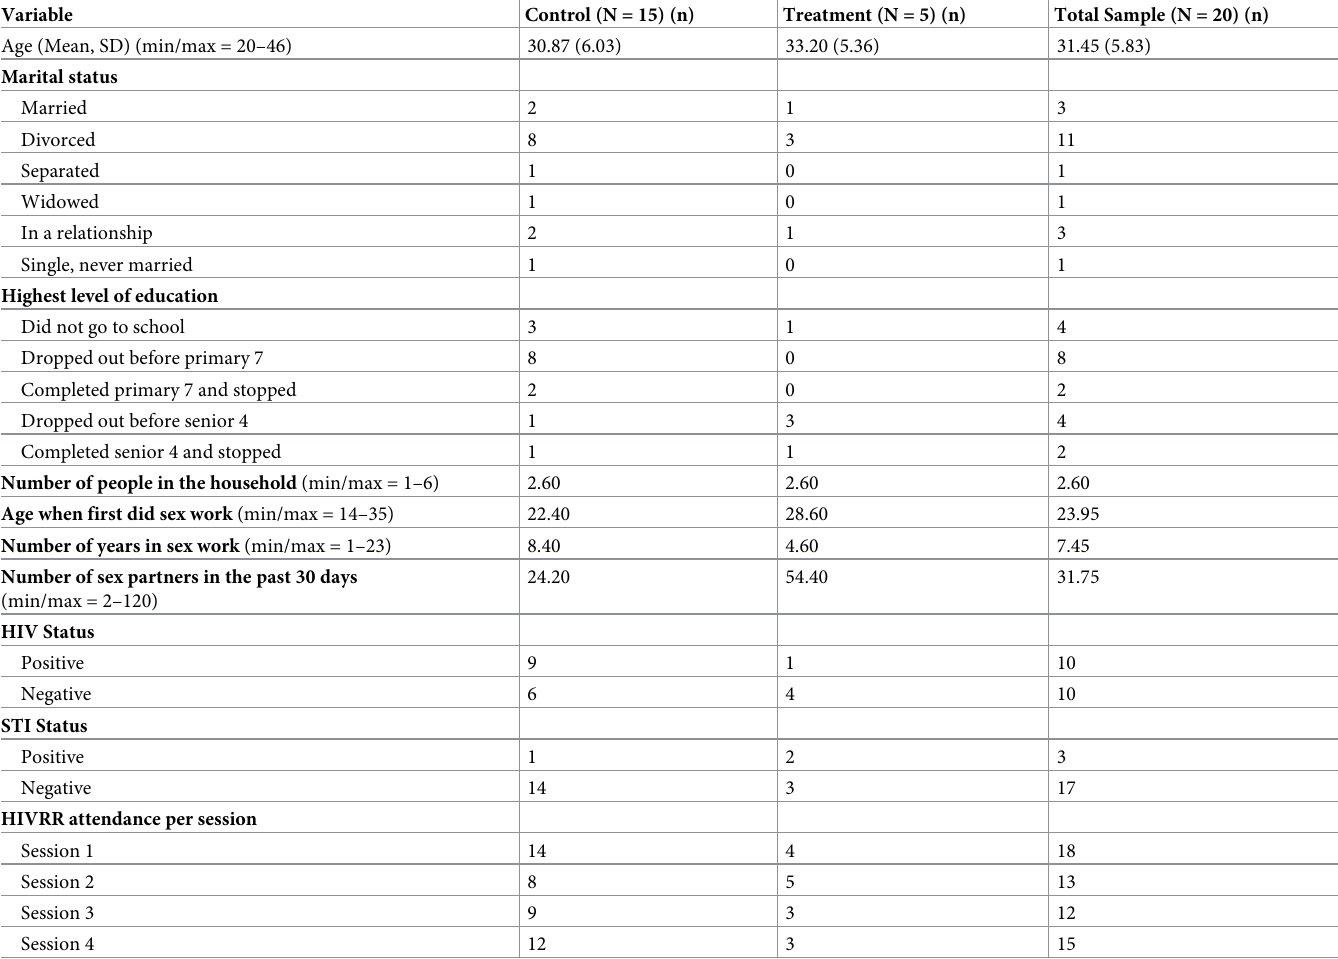
Table 1. Participant demographics per study